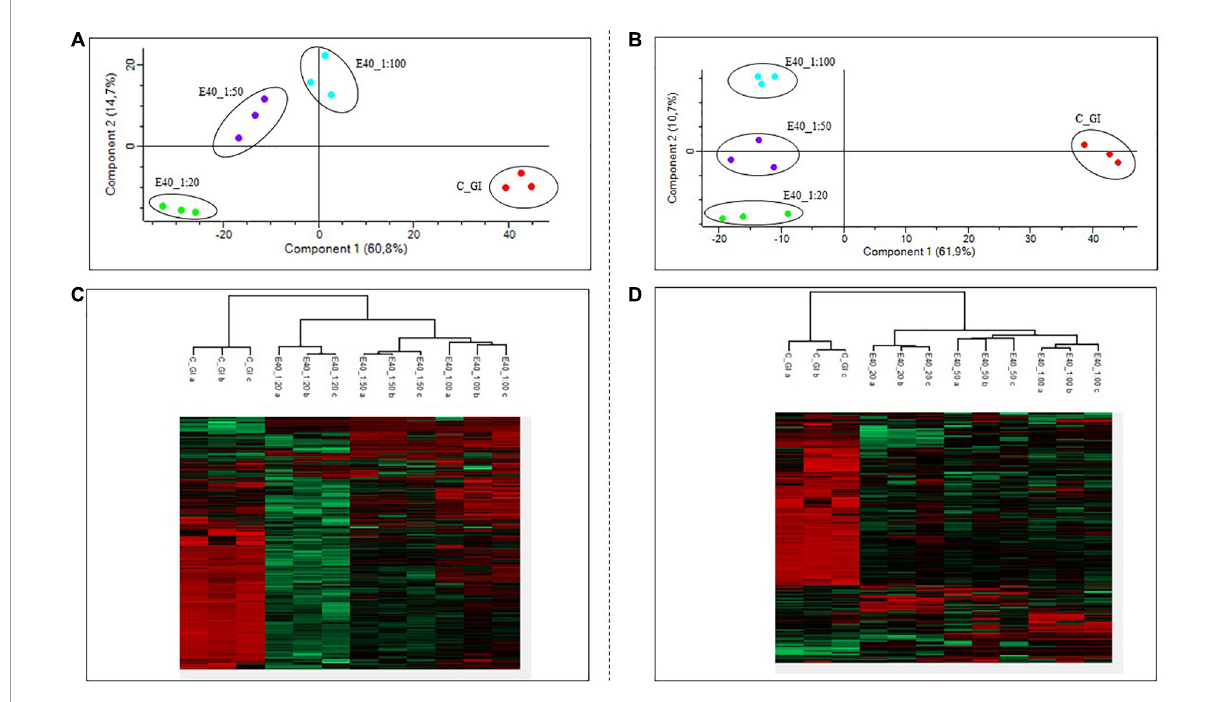
FIGURE4 PCA and heat map of all GI peptides identified by LC-MS/MS for bread (A,C) and pasta (B,D) . (A,B) PCA of the technical replicates, reflecting the differences between the resistant peptides of GI control and that of digesta at dose-dependent E40 detoxification (1:20, 1:50, and 1:100). (C,D) Heat map of the technical replicates showing the LC-MS/MS intensity of GI-resistant peptides in control samples and digesta with E40 treatment. Red color and green colors represent high and low intensity, respectively; values are scaled across columns, generating column z-scores. Identified sequences are reported in Supplementary Table 2